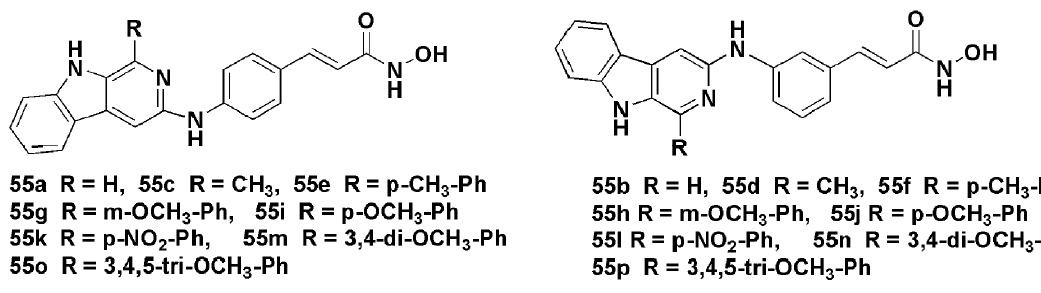
Figure 14. Chemical structures of compounds 55a–p [30].